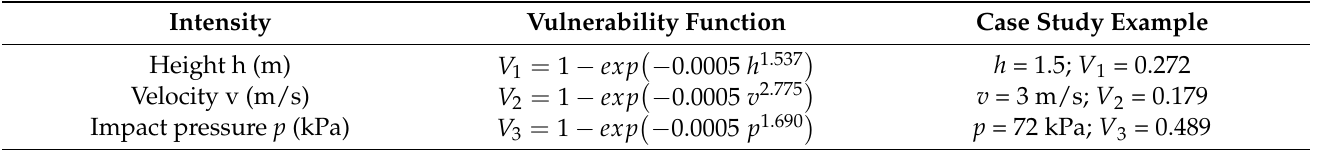
Table 4. Vulnerability function proposed by [33] for reinforced concrete structures.